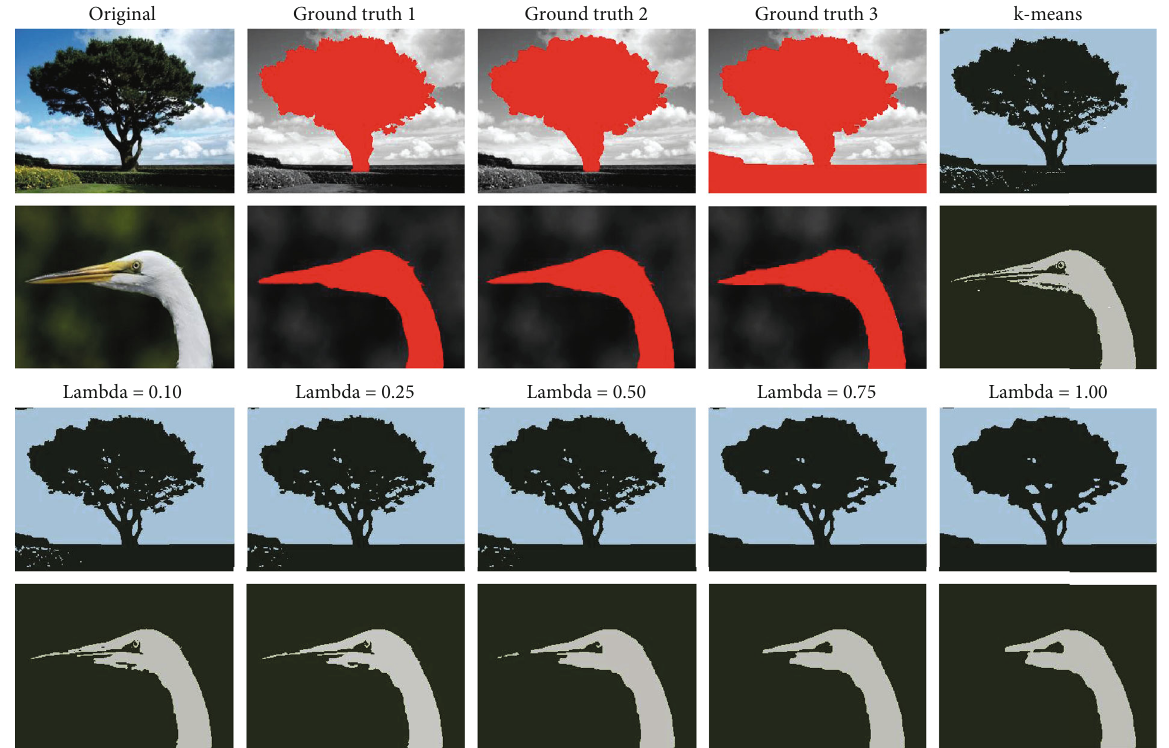
Figure 1: Segmentation results for selected two images using the Douglas-Rachford algorithm.